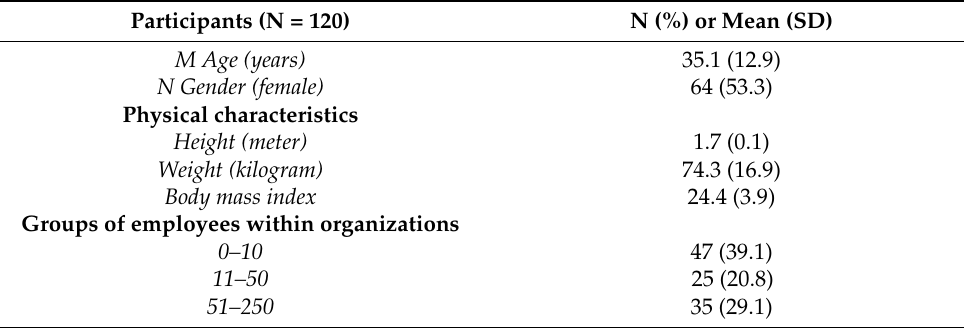
Table 1. General characterization of the